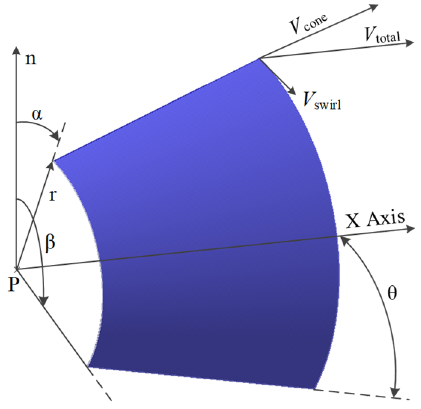
Figure 4. The schematic of the injector. Some water droplets might break up after the heat transformation and aerodynamic interaction with incoming flow successively. Dynamic drag model was utilized to calculate the droplet drag coefficient, accounting for droplet deformation. Wave model was adopted to evaluate second breakup. When the water droplet was ejected from the injector, it